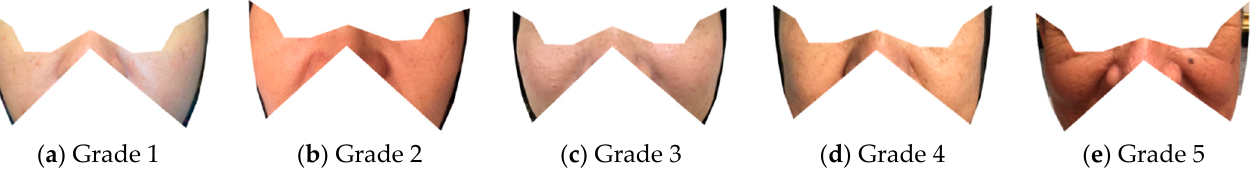
Figure 6. Examples of the five grades of cheek wrinkles (regions are similar to Figure 2d).